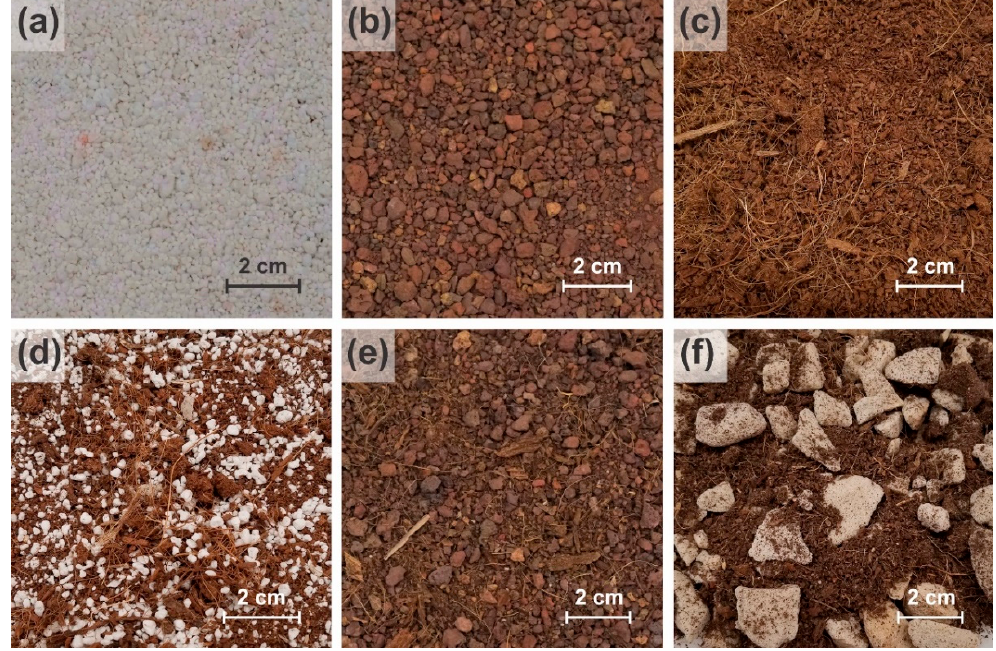
Figure 1. Investigated soilless substrates and substrate mixtures. ( a ) perlite, ( b ) tuff, ( c ) coconut coir, ( d ) 50/50 vol.-% perlite/coconut coir mixture, ( e ) 70/30 vol.-% volcanic tuff/coconut coir mixture, and ( f ) 50/50 vol.-% foamed glass aggregate/coconut coir mixture.